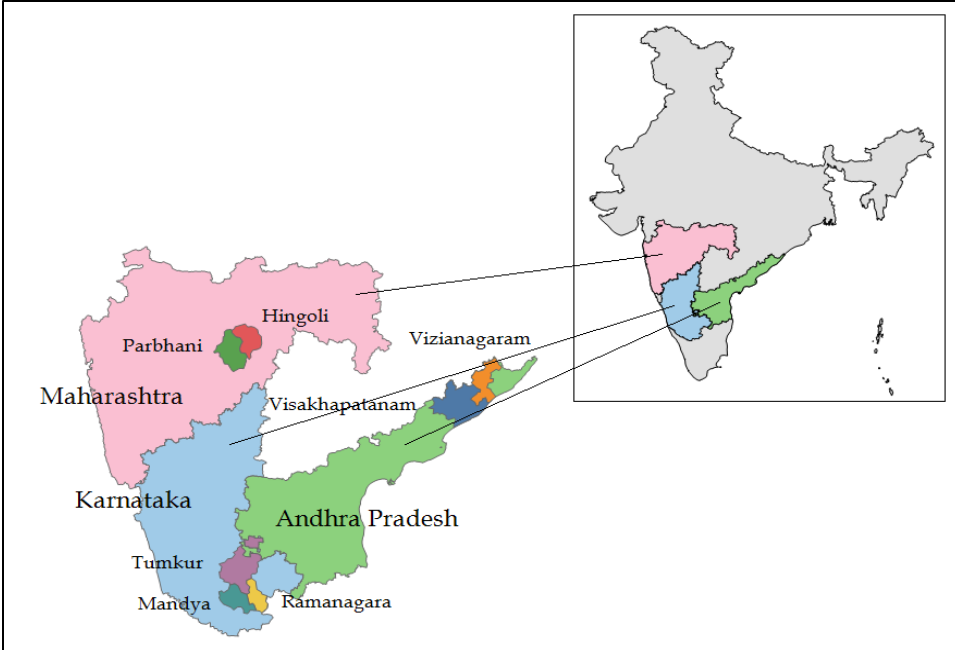
Figure 1. States and sample districts for the study.